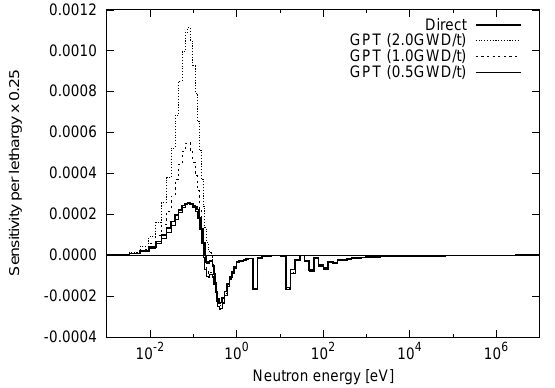
Figure 4. Sensitivities of U-235 number density to Gd-157 (n, γ ) cross section